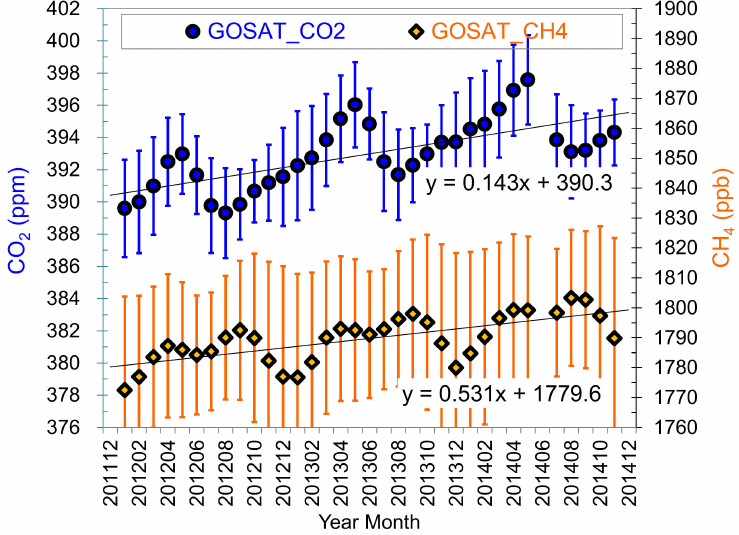
Figure 4. Time series of CO 2 and CH 4 derived from the GOSAT satellite in the study domain. Circle and diamond symbols denote the averaged concentrations of over the complete domain in Figure 1 and error bars show the standard